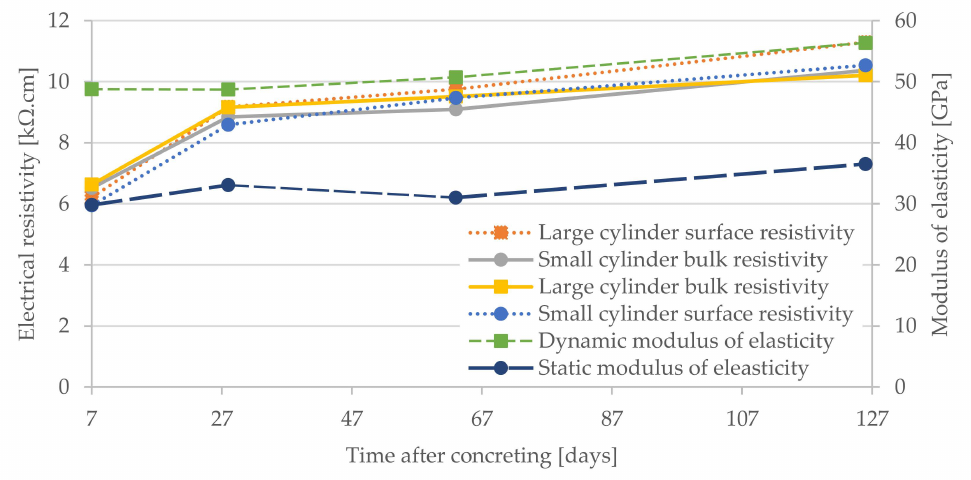
Figure 4. Time-dependent results of electrical resistivity and modulus of